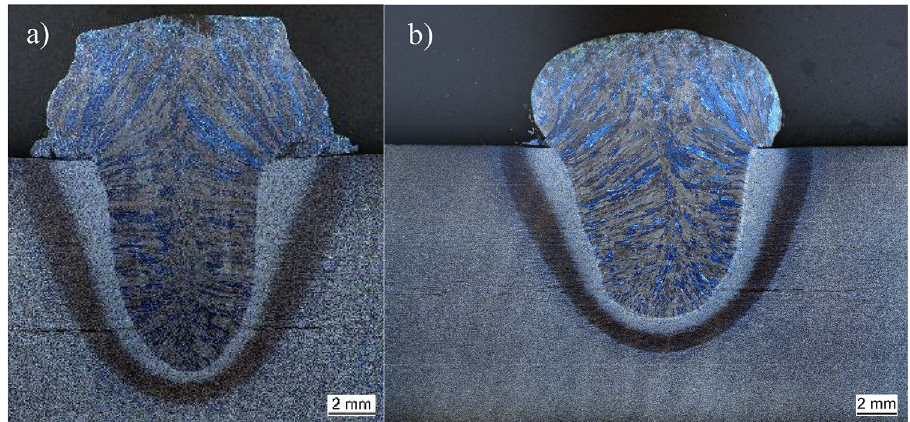
Figure 8. ( a ) Cross-section 500A, 35 V, 16 bar. ( b ) Cross-section 350 A 40 V 9 bar.